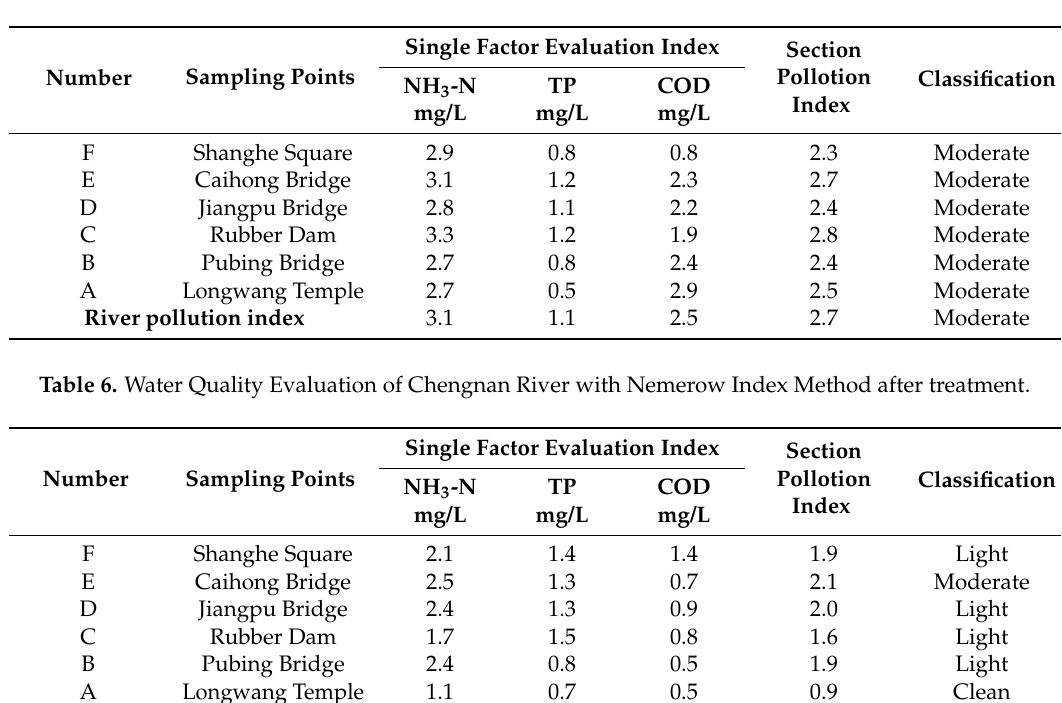
Figure 6. The changes of Nemerow pollution index before and after the microbial treatment. Table 5. Water Quality Evaluation of Chengnan River with Nemerow Index Method before treatment.